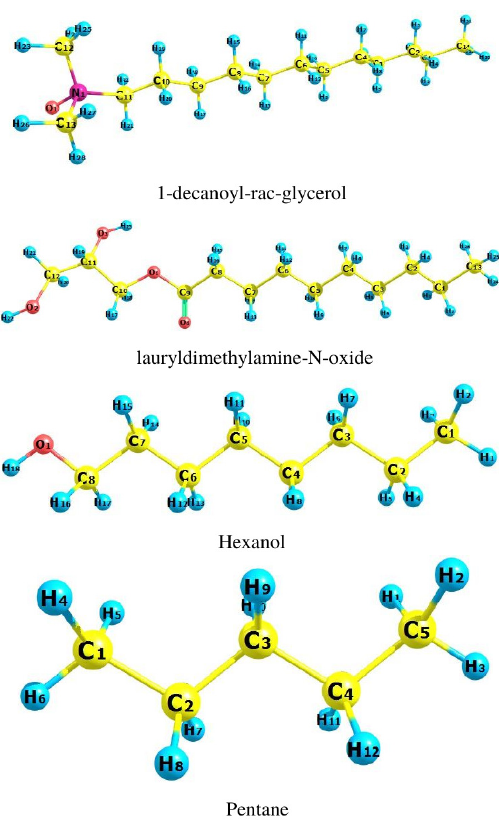
Figure 1: Optimized geometries of studied molecules, with